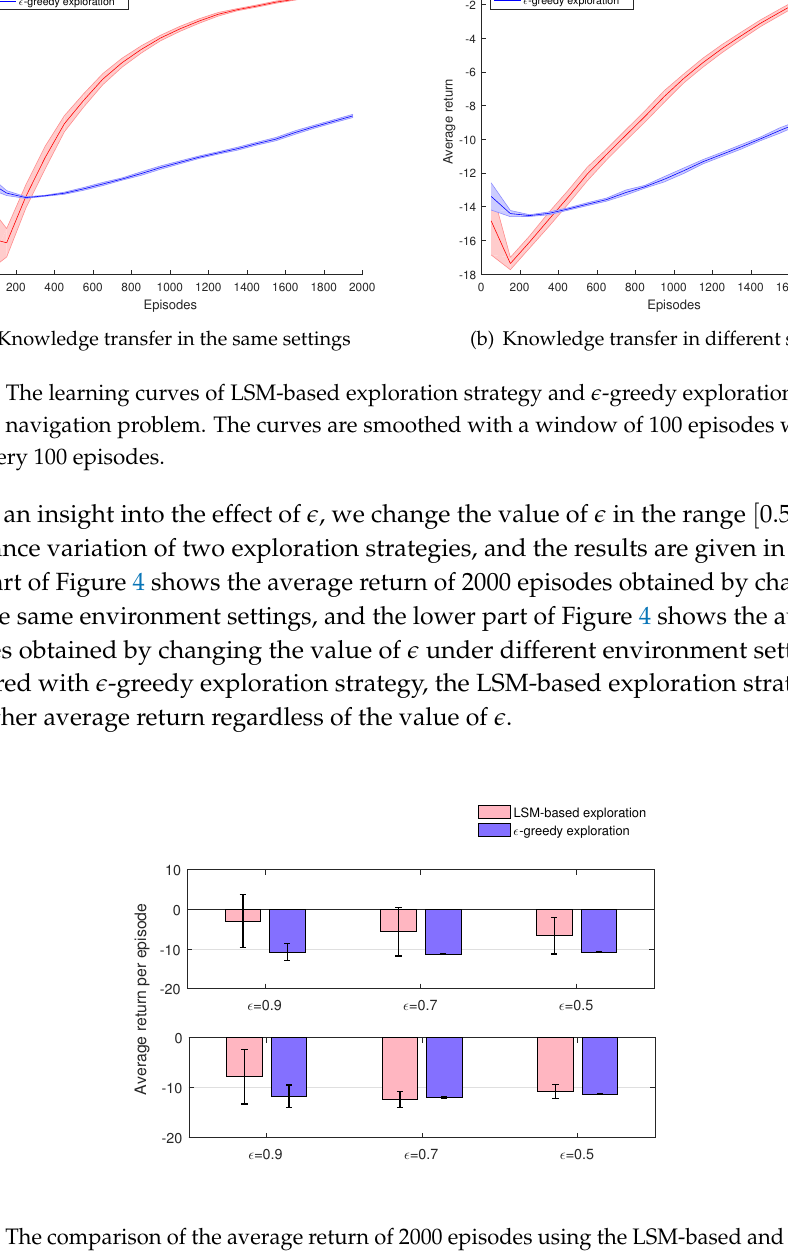
Figure 4. The comparison of the average return of 2000 episodes using the LSM-based and the (cid:101) -greedy exploration strategies, and the values of (cid:101) are 0.9, 0.7, and 0.5 respectively from left to right. The upper part shows the results under the same environment settings and the lower part shows the results under different environment